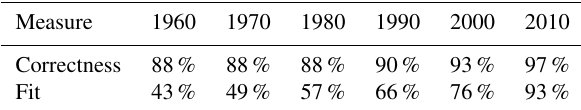
Table 6. Scores in two measures of accuracy of gridded population estimates (simple average for all